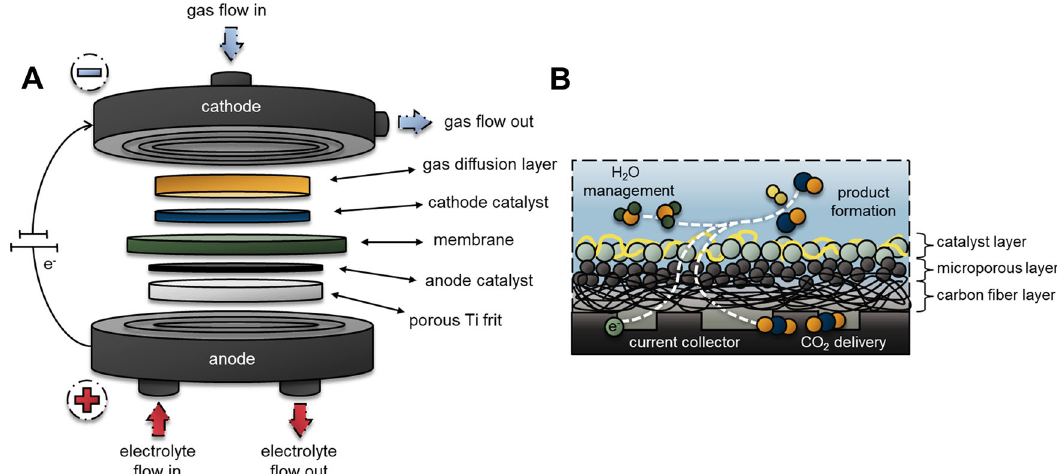
Fig. 7 Illustration of the applied electrolyzer cell and the processes occurring at the cathode. A Schematic illustration of the zero-gap electrolyzer cell. B Schematic illustration of the structure of the gas diffusion electrode